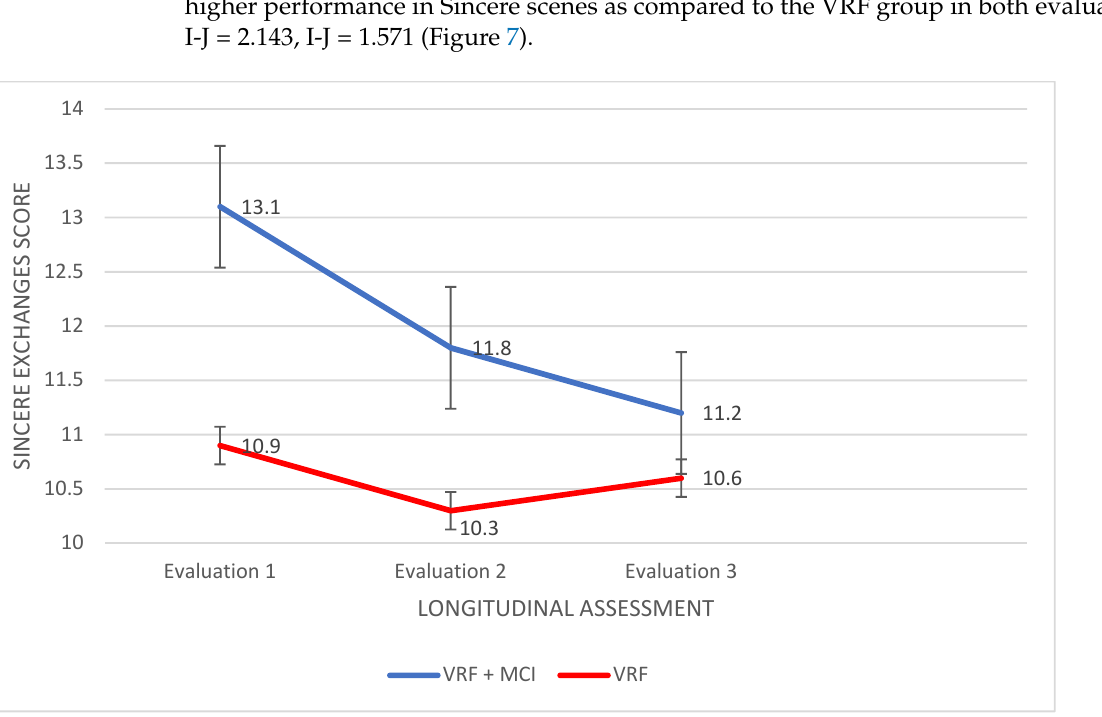
Figure 7. Performance of adults with VRF and adults with VRF + MCI in Sincere Exchange condition of the TASIT (ToM abilities).